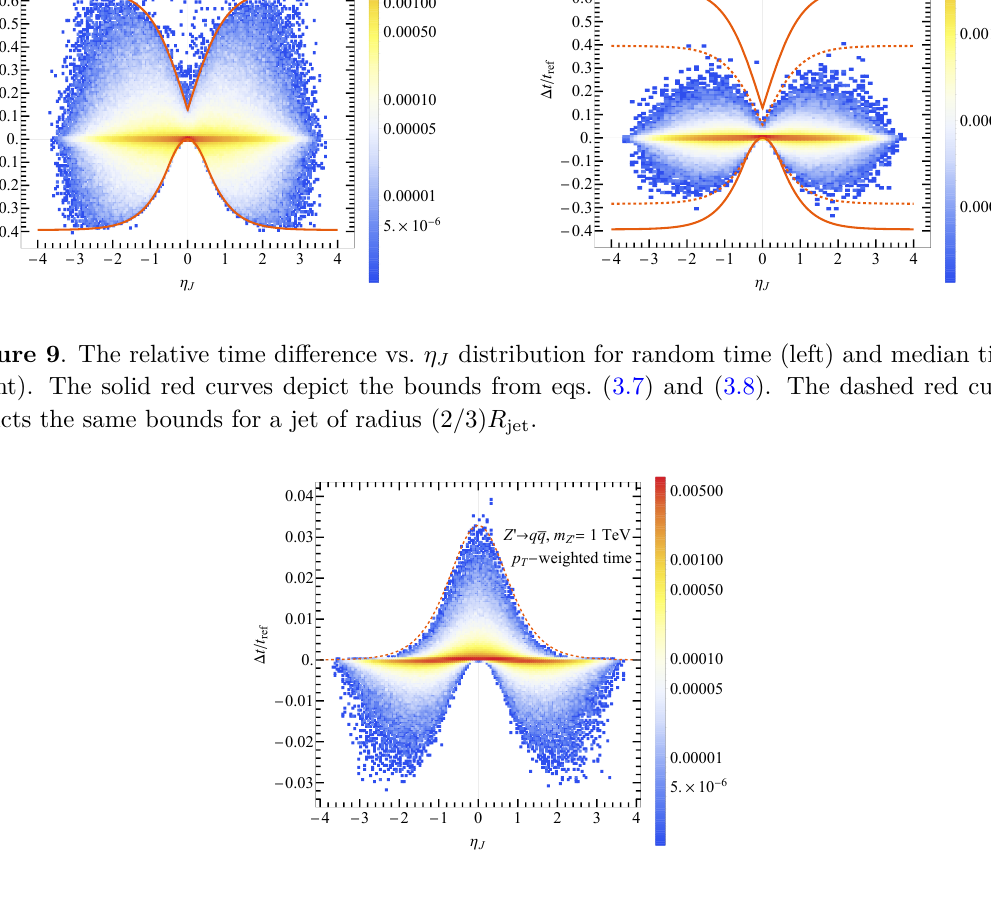
Figure 10 . The relative time difference vs. η J distribution for p T -weighted time. The dashed red curve depicts the relation in eq.